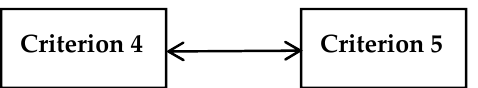
Figure 4. Impact-relation map for the criteria of noncommunicable diseases.